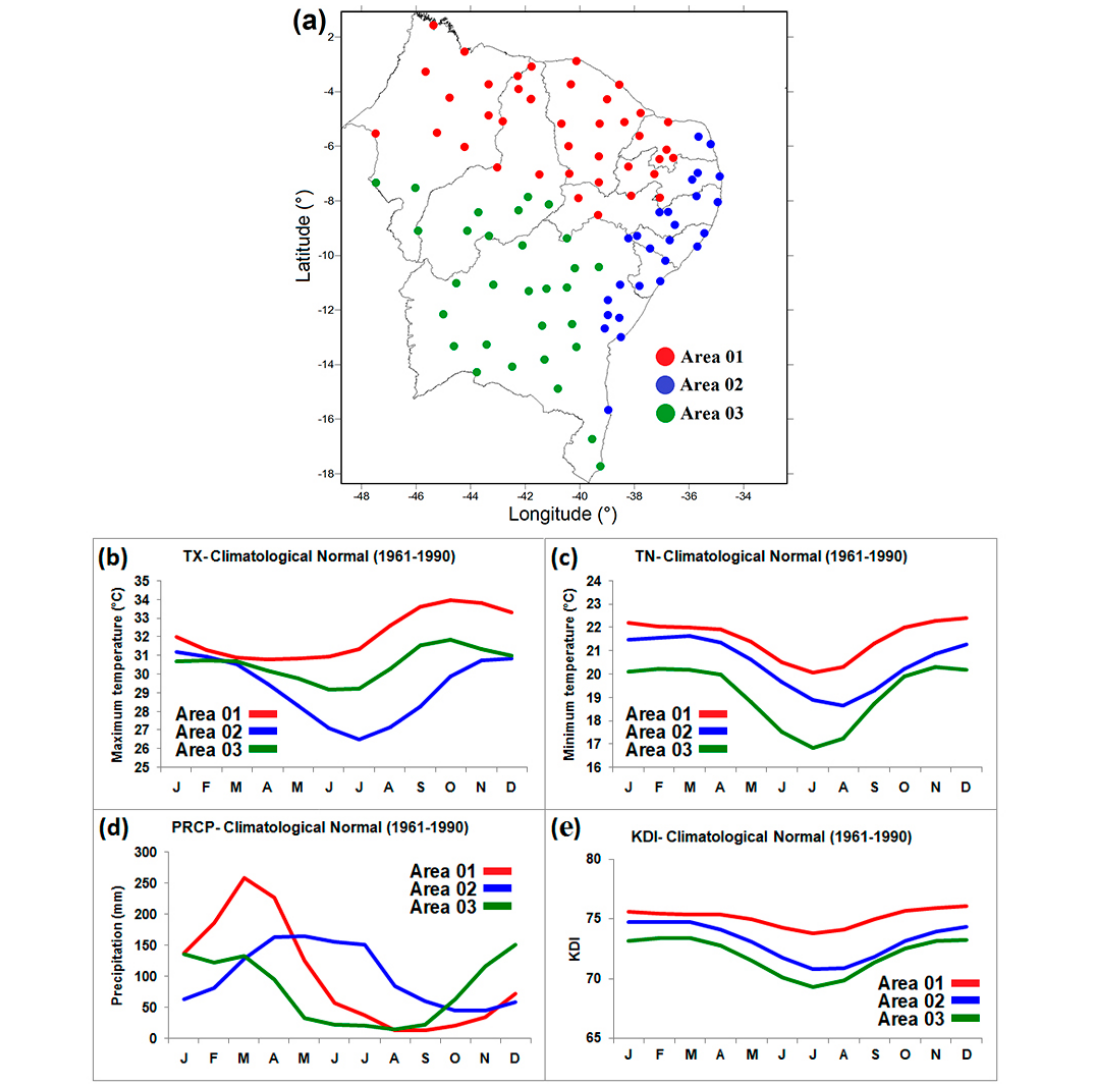
Figure 2. (a) Spatial distribution of the stations and identification of the three large areas (climate subregions), separated by color, (b) climatology observed in 1961-1990 for TX in each area, (c) the same as b, but for TN, (d) the same as b, but for PRCP and (e) the same as b, but for